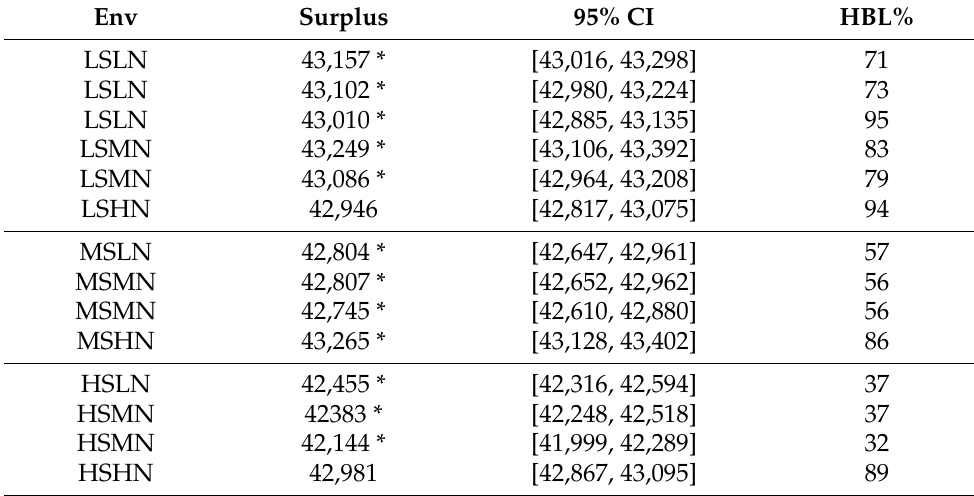
Table A2. Similar to Table A1 above. Surpluses marked with asterisks indicate statistically signif- icantly higher surpluses than those achieved in their corresponding markets with spoofing (see Table A4). N = 65 without